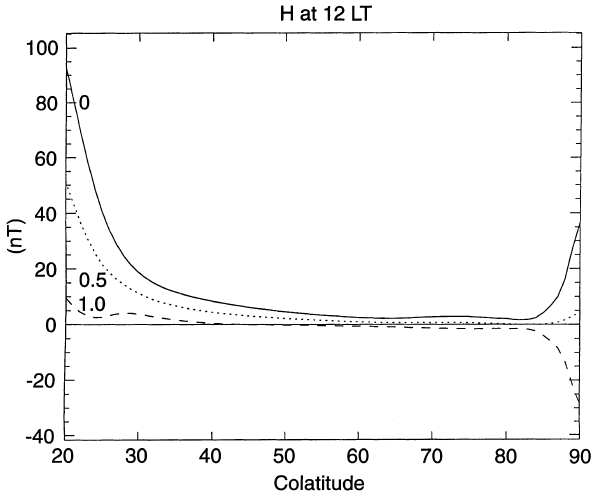
Fig. 6. Latitudinal variations of H component magnetic fields in the 12 LT meridian calculated for the three models of source current composition. Solid , dotted and dashed lines are for the results with the ratio of region 2 current intensity 0.0, 0.5 and 1.0 to that of region 1 current, respectively